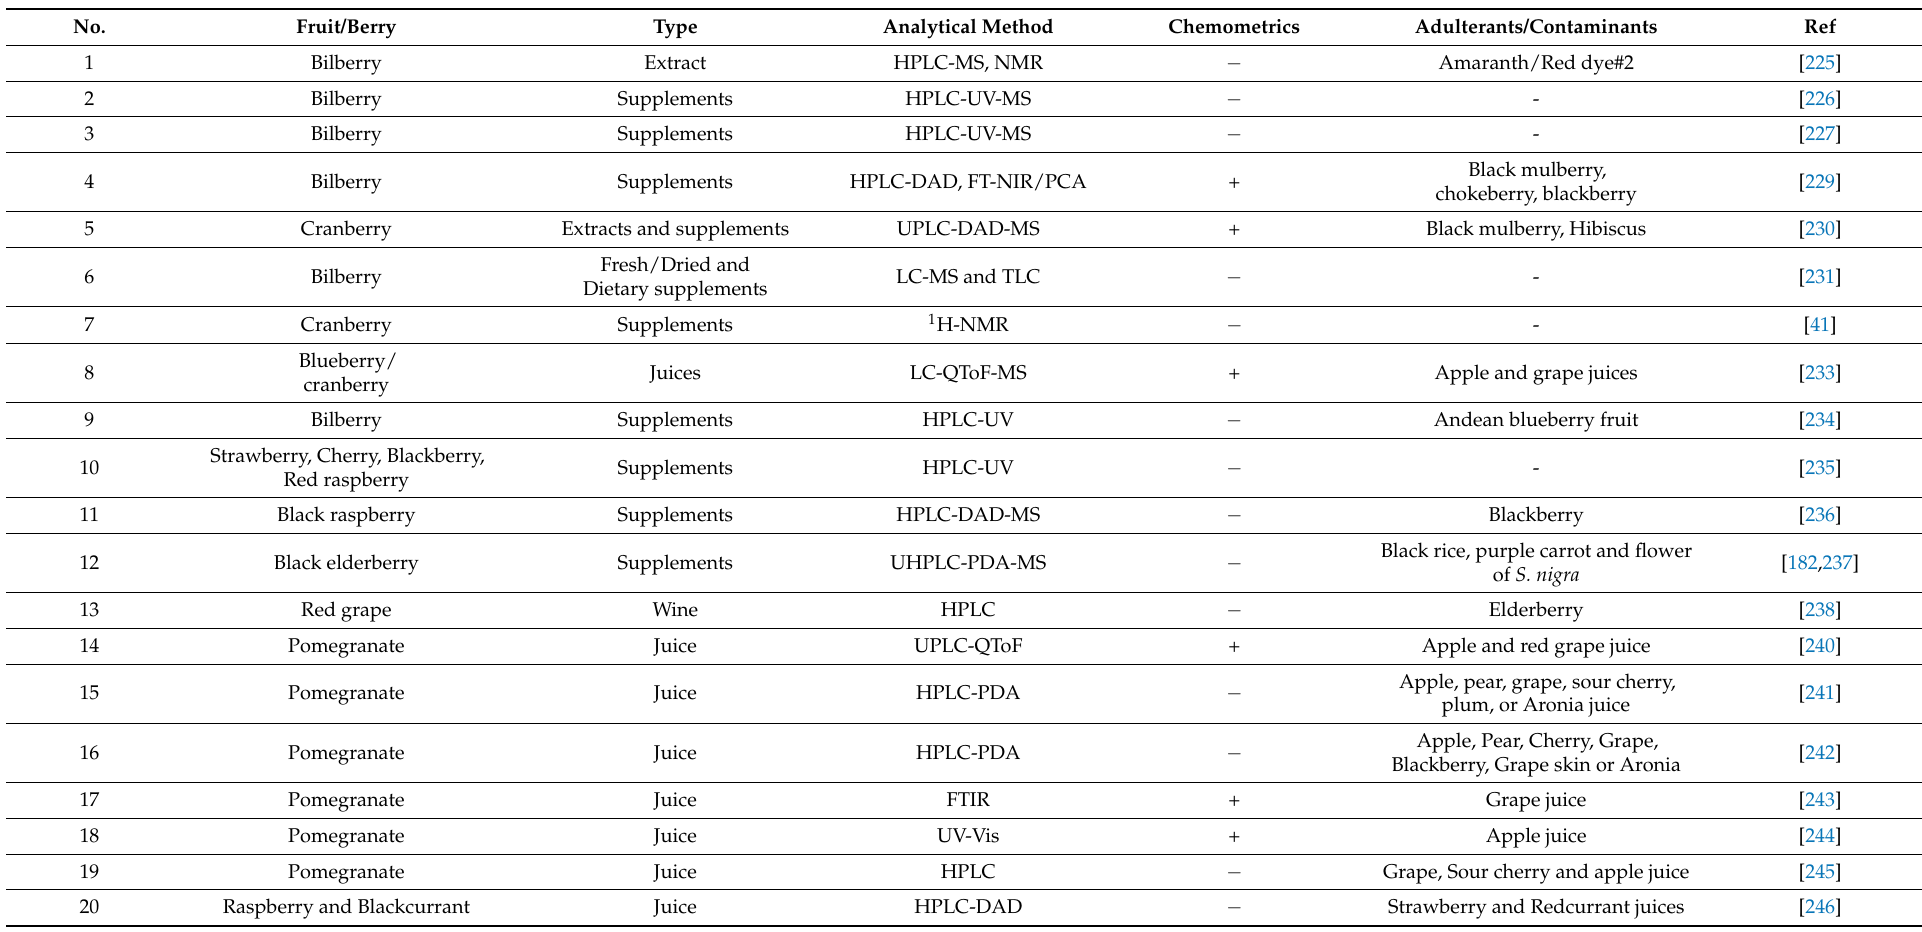
Table 6. Summary of analytical methods for determining the adulteration of fruit/berries and fruit/berries food-based products concerning